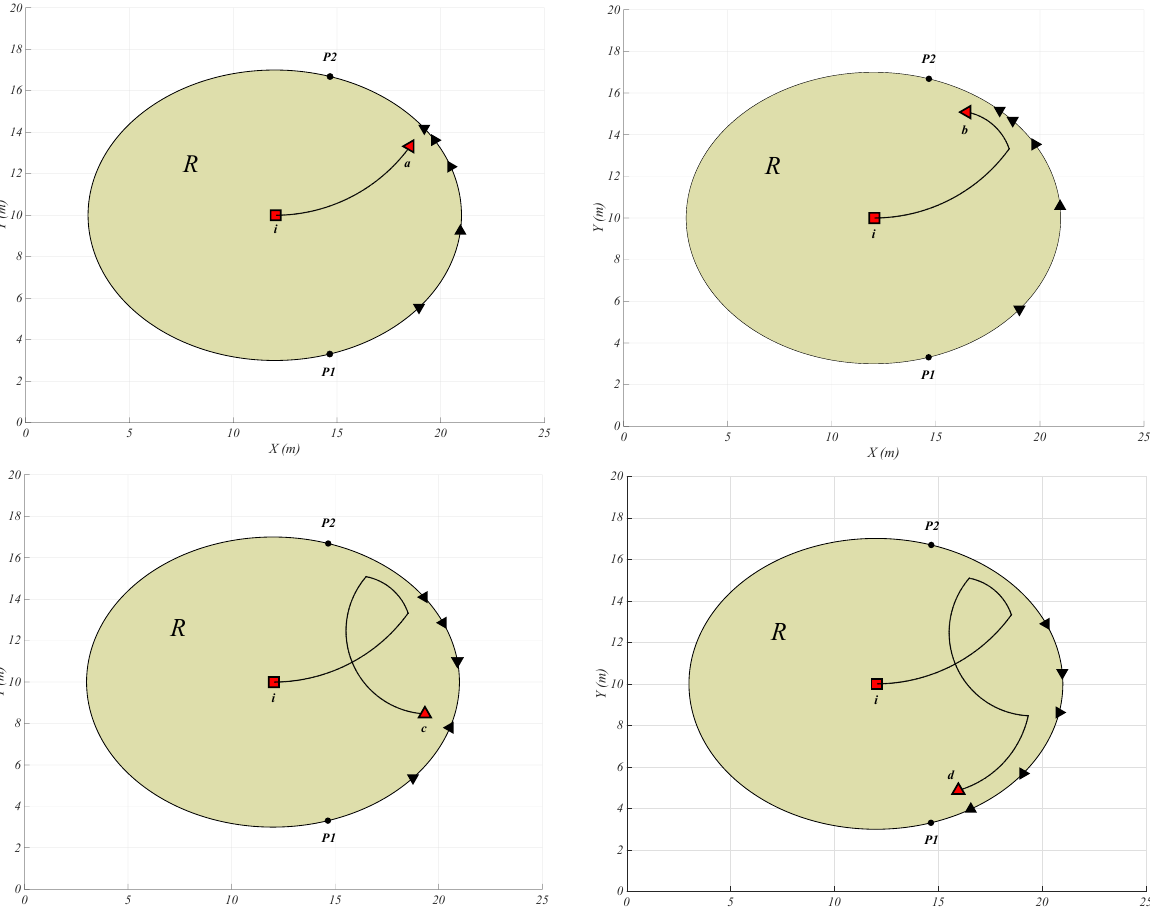
Figure 4. The intruder trajectory and the positions and the motion directions of the USVs when the intruder is at points a , b , c and d